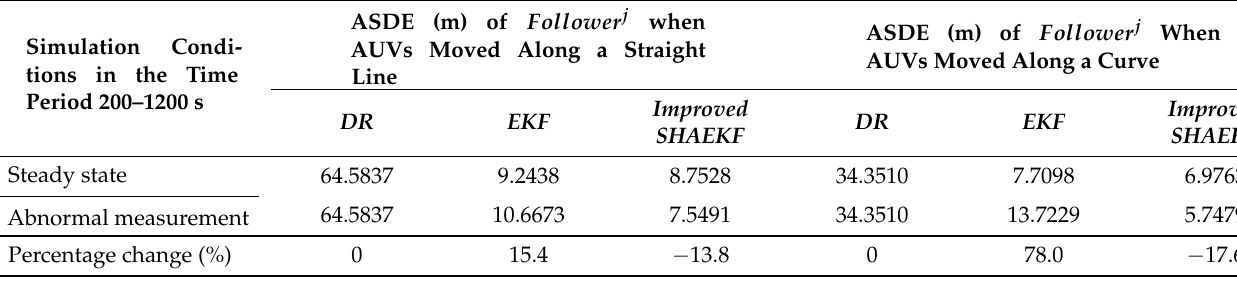
Table 3. Comparison of ASDE of each